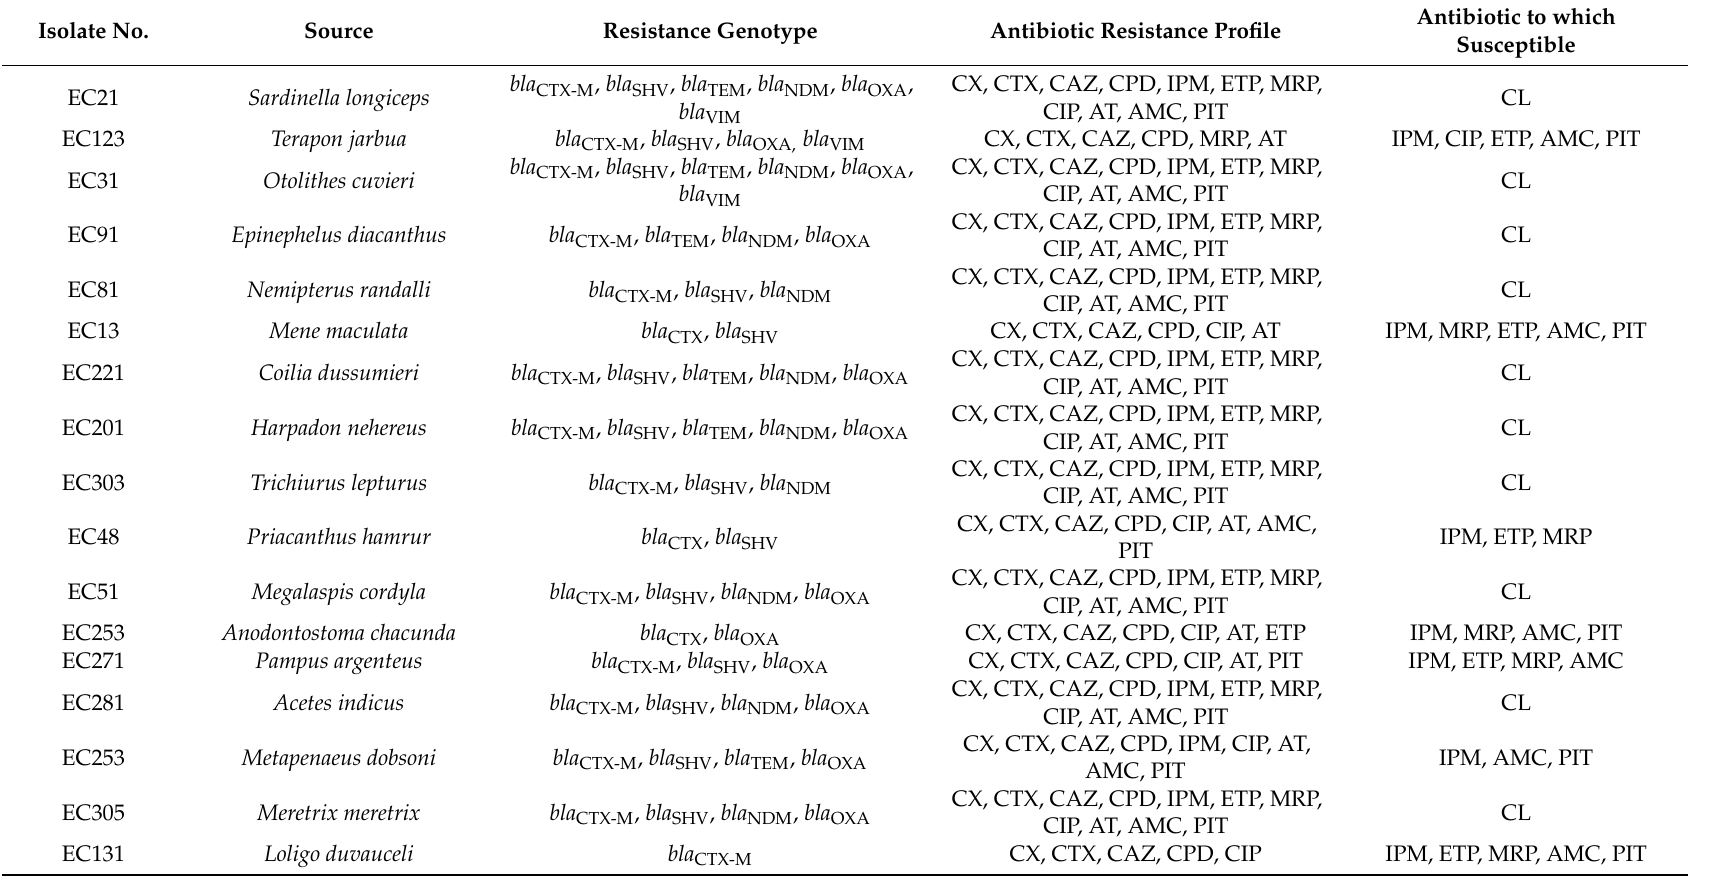
Table 5. Characteristics of the E. coli isolates exhibiting the highest resistance phenotypes from each sample type. Isolate